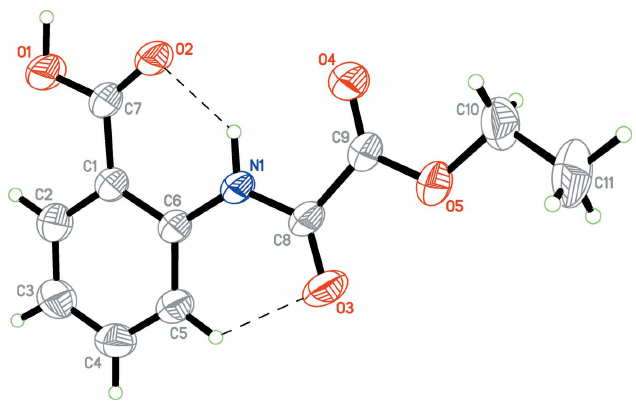
Figure 1 Molecular structure of the title compound with the atom